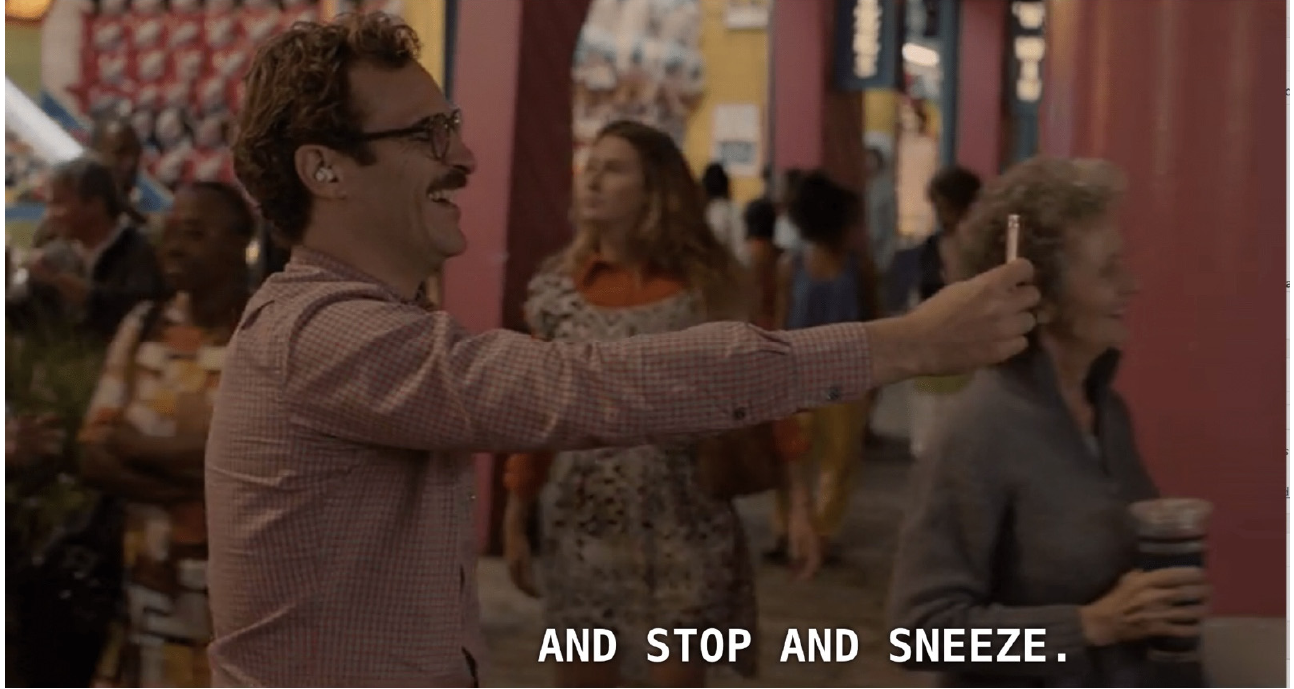
Figure 5. Samantha guides Theo through a carnival and tells him to sneeze. (Screenshot created by author). But Samantha’s strong capacity for kinesthetic empathy leads to frustration. One Long story short, the evening is a catastrophe, but it is not Samantha’s fault. The surrogate, Isabella, arrives, and Theodore gives her an earbud that allows Samantha to communicate with her without Theodore being able to hear and a small, freckle-sized camera to place next to her nose, so that Samantha can see from Isabella’s point of view. Isabella is a classic example of a videogame avatar and an instantiation of Chin’s theory of the way kinesthetic empathy is produced through the constitutionally contradictory player/avatar relationship. The player—here, Samantha—observes both the avatar and what the avatar observes. She manipulates the avatar (through verbal cues), while also imagining herself as being the avatar. Isabella performs effectively the cognitive, social, visceral, and fantasy functions of the avatar. But she is also sensitive to the internal life of the avatar, respecting Isabella’s autonomy as a performer. “Does my body feel nice?” Samantha asks, using the first-person perspective to describe her performance with Isabella. In contrast, Theodore cannot (or will not) play the game. “Come on,” Samantha enjoins him, “Get out of your head and kiss me.” And still he refuses. Samantha changes tack, hoping a lighter touch might work: “Come on, Theodore, don’t be such a worrier. Just play with me” (see Figure 6). Samantha has practice with avatars—and a willingness to imagine herself beyond her own body. But Theodore is incapable of joining in. He calls an end to the game, Isabella is humiliated, and Samantha begins to recognize the limits of her relationship with Theodore. Theo cannot do kinesthetic